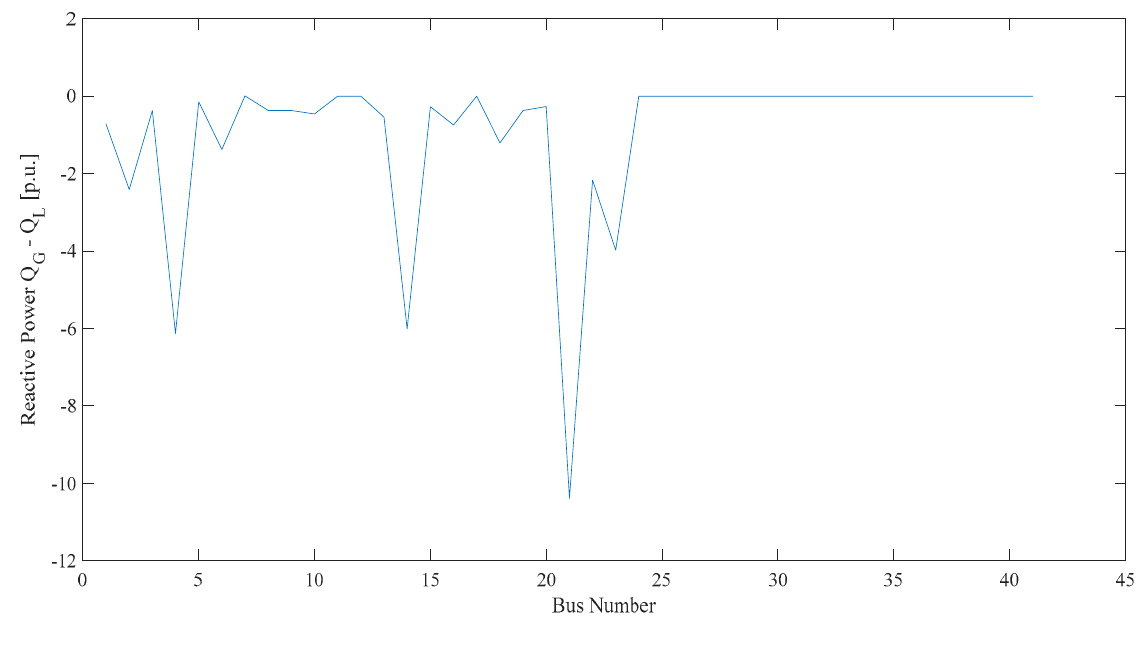
Figure 9. Reactive power output of the compensated Nigerian 41 bus transmission network with IPFC.